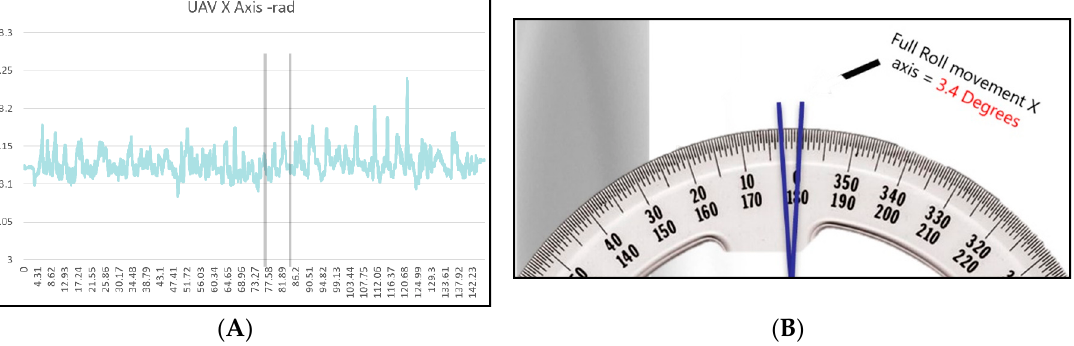
Figure 22. ( A ) Graph displaying the UAV roll along the x -axis. ( B ) Image displaying the full roll of the UAV. It rolled within a 3.4° envelope along the x -axis.